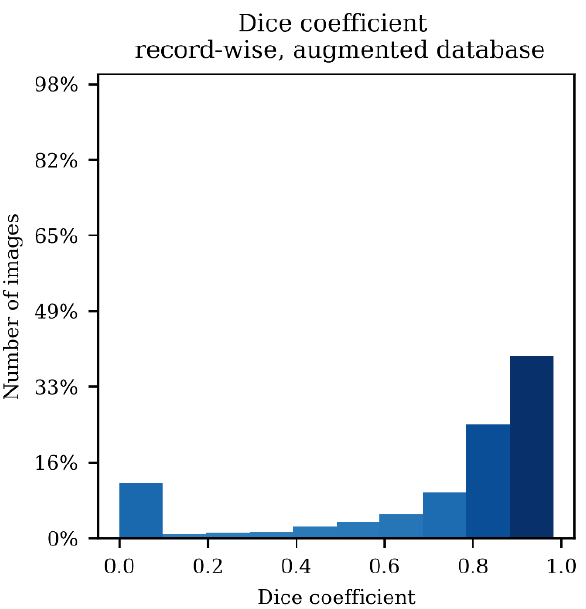
Figure A3. Dice coefficient histograms for segmentation results on a test set for a network trained on the augmented database with 5 -fold record-wise cross-validation.